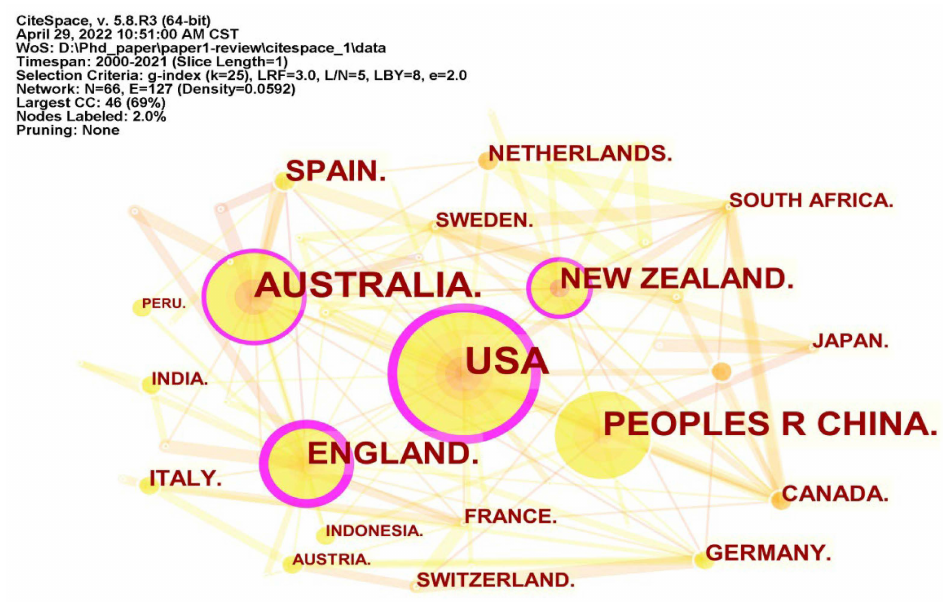
Figure 2. Collaborative network between countries or